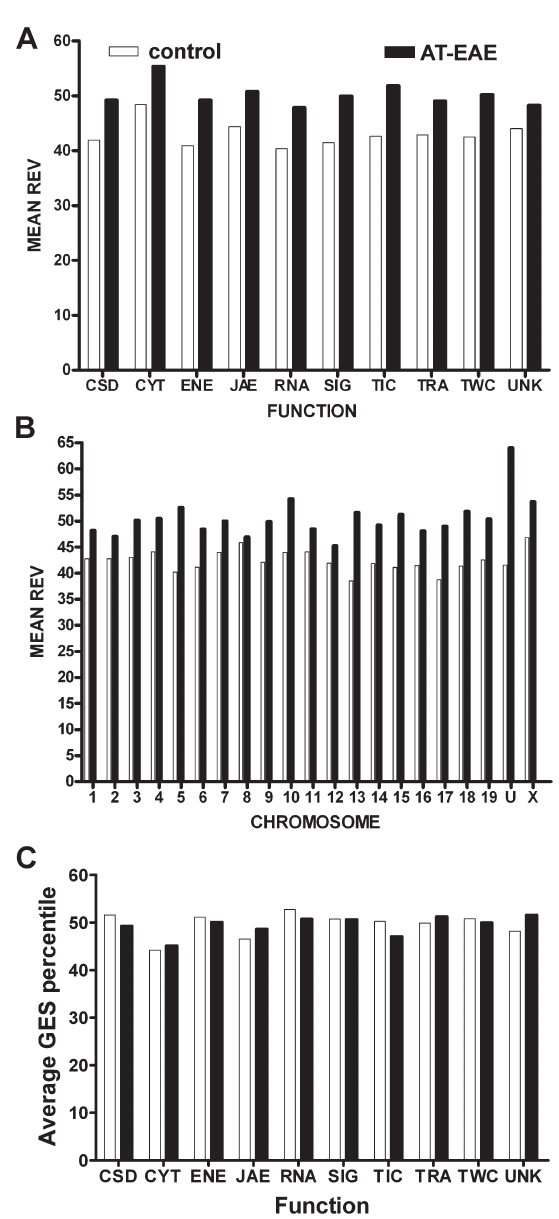
Figure 2. Regulation of the mean relative expression variability (REV) of gene cohorts sharing the same molecular function (A) or chromosomal location (B) in spinal cords of AT-EAE mice compared to control mice. ( C